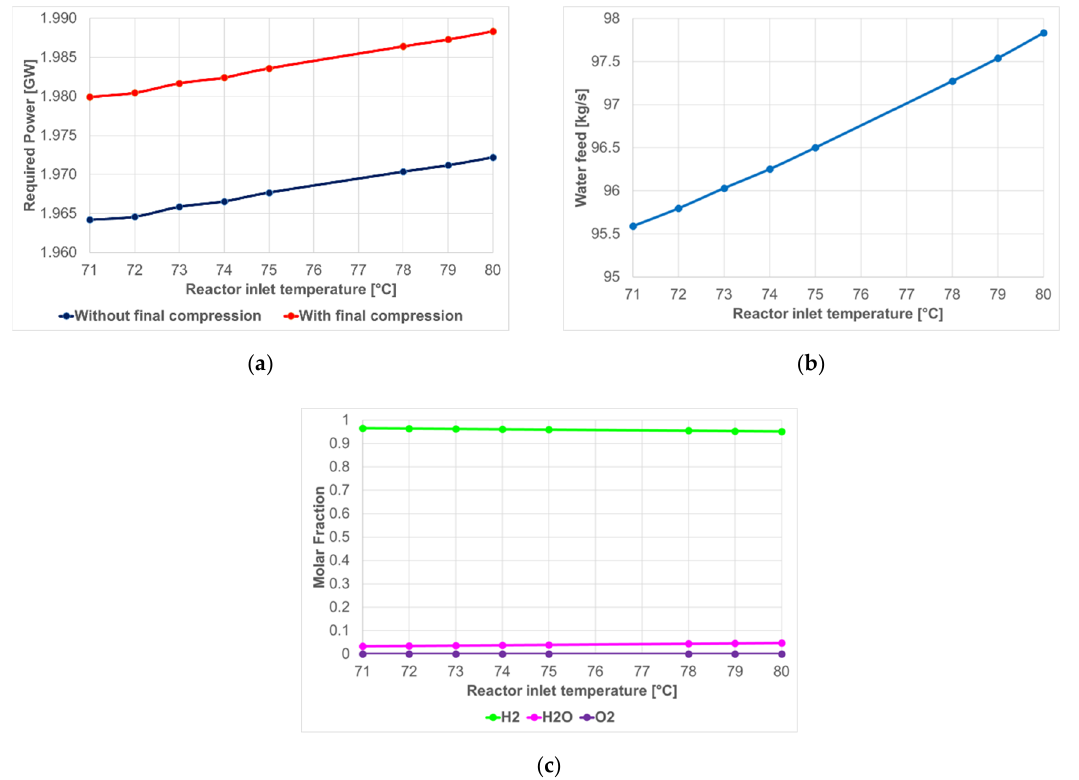
Figure 8. Results related to reactor inlet temperature changes for 10 kg/s H 2 production: ( a ) Total required power; ( b ) water feed rate; and ( c ) molar fraction in gas flow obtained in cathode section.